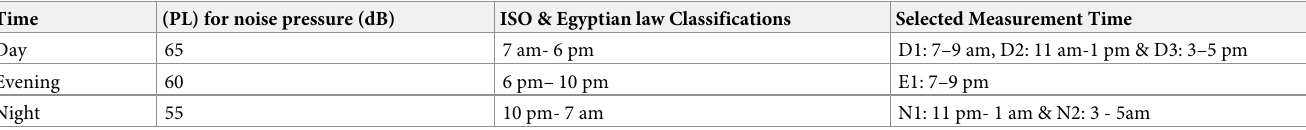
Table 5. The measurements timing that are selected for the study. Time (PL) for noise pressure (dB) ISO & Egyptian law Classifications Selected Measurement